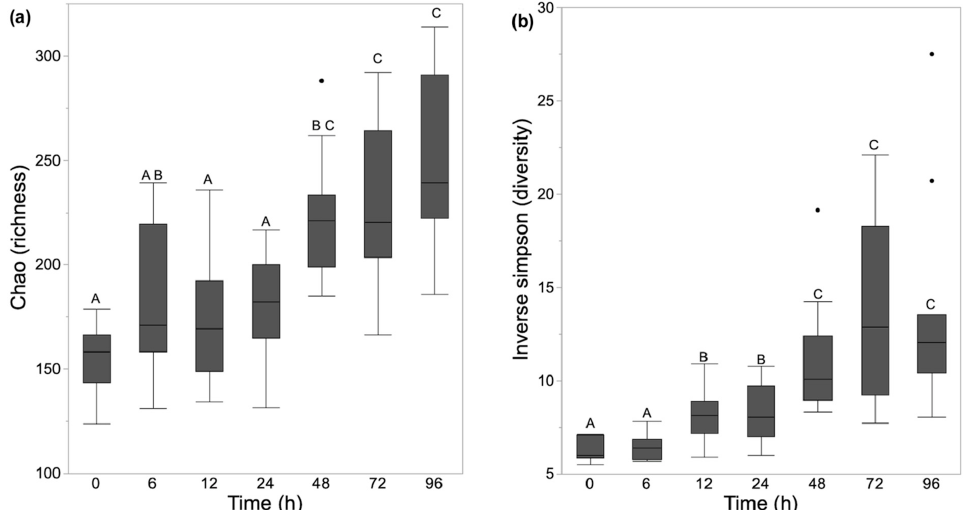
Figure 1. Alpha diversity measurements of the equine fecal samples stored at ambient temperature for 0 h to 96 h before freezing and sample processing represented by box and whisker plots. ( a ) Richness (Chao-1 index); ( b ) Diversity (Inverse Simpson’s diversity index). The time points that are marked with the same letter or letters (A, B, or C) had no statistically significant differences between groups ( p > 0.05). The center line denotes the median value (50th percentile), while the upper and lower bounds of each box represent the 75th and 25th percentiles, respectively. The whiskers mark the 95th and 5th percentiles. Outliers are denoted with dots (·).